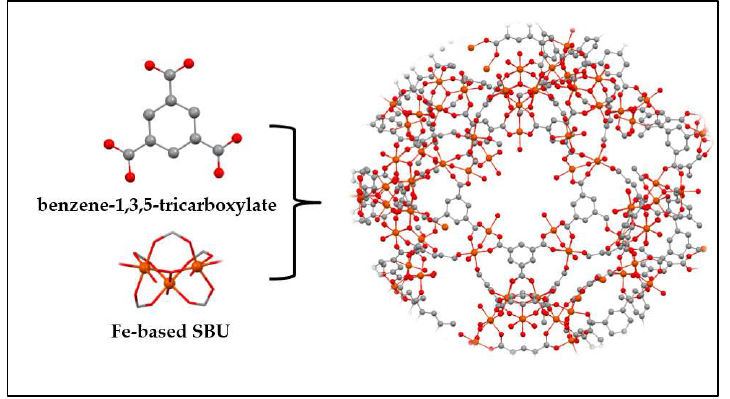
Figure 1. Crystal structure of MIL100(Fe) from the reaction between the benzene-1,3,5-tricarboxylate and the iron(III)-based cluster.